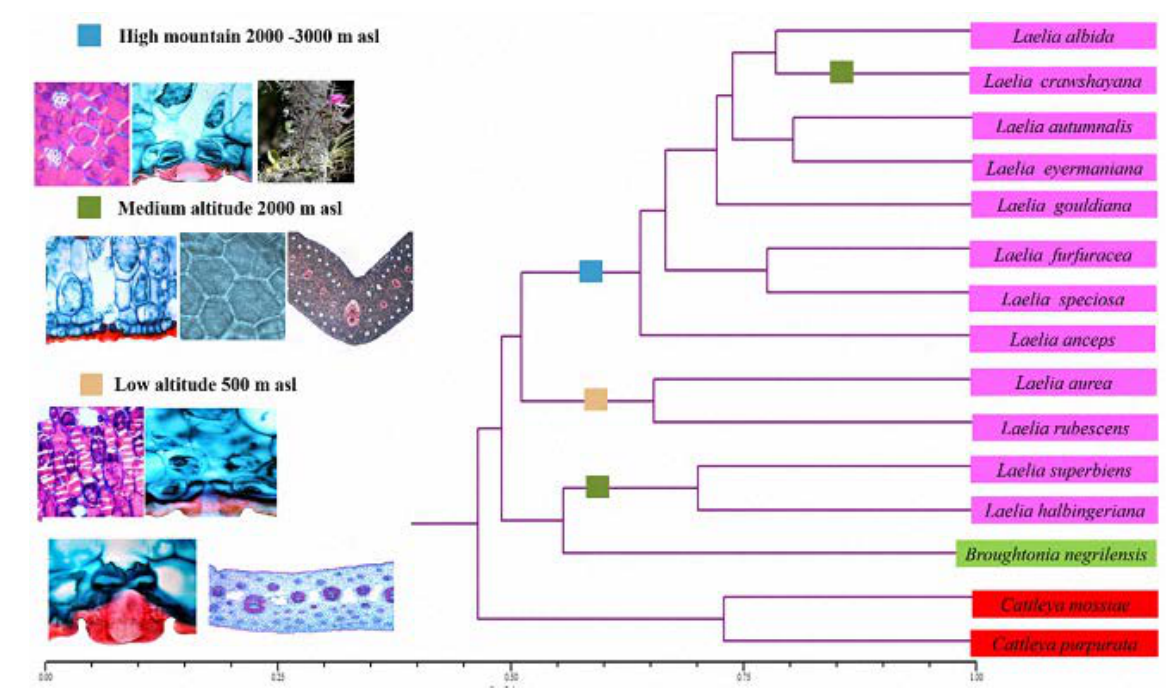
Figure 8. Phenogram of the anatomical and morphological characters with 15 species evaluating the taxonomic distance coefficient and the average linkage grouping algorithm (UPGMA). Note: the boxes represent an altitudinal distribution interval: blue (high mountain 2000–3000 m asl), green (medium altitude 2000 m asl), light brown (low altitude 500 m asl). The colors in the species represent the same genus: Laelia (pink), Broughtonia (green) and Cattleya (red).